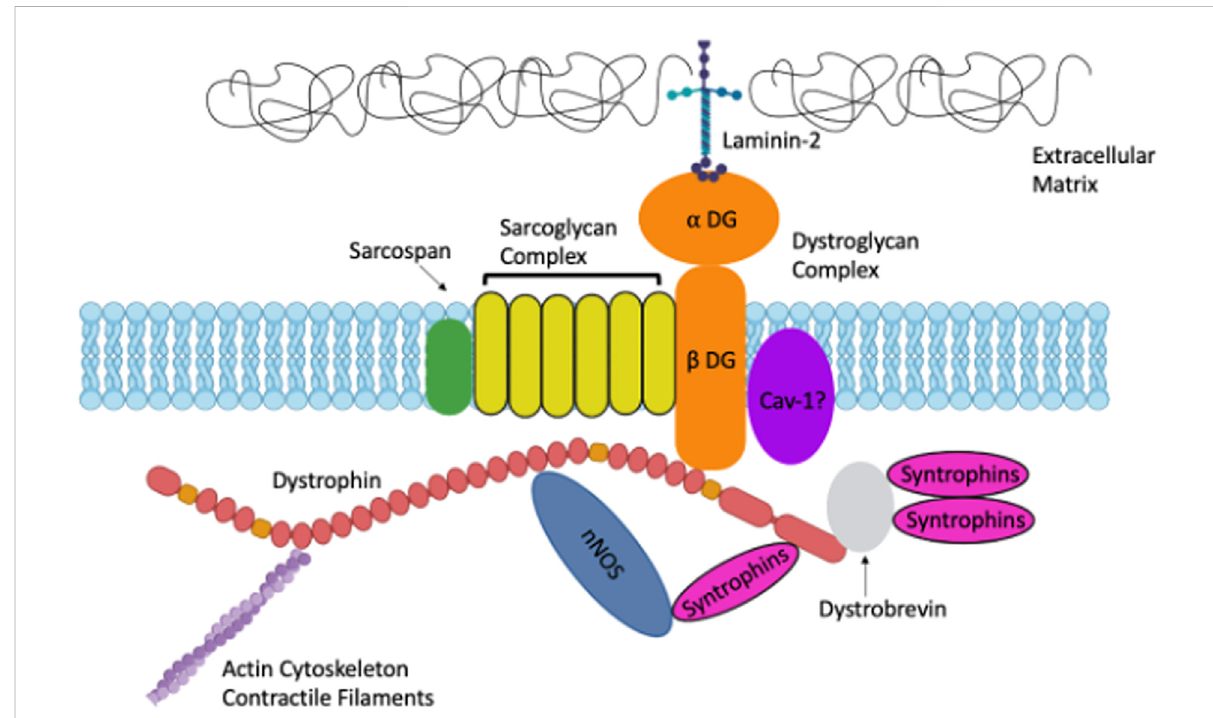
FIGURE 1 A. Schematic representation of Dystrophin and the Dystrophin-Associated Proteins in muscle including: Dystroglycans, Sarcoglycans, Syntrophins, Caveolins and more. Created with